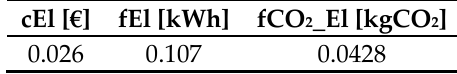
Table 2. Non ‐ efficient Dishwasher Electricity Multiplier coefficient, referred to 1 L of water: cEl is the electricity cost multiplier, fEl is the electricity multiplier and fCO 2 the CO 2